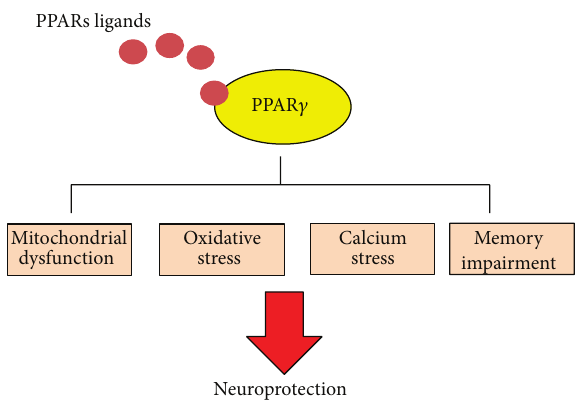
Figure 2: Activation of PPAR 𝛾 improves neuronal health . Several neurodegenerative diseases showed clear deficiencies in mitochon- drialfunction,oxidativestress,andmemoryimpairment.Activation of PPAR 𝛾 by natural ligands or TZDs could prevent these neurode- generative changes mainly improving mitochondrial function and increasing antioxidant capacity in